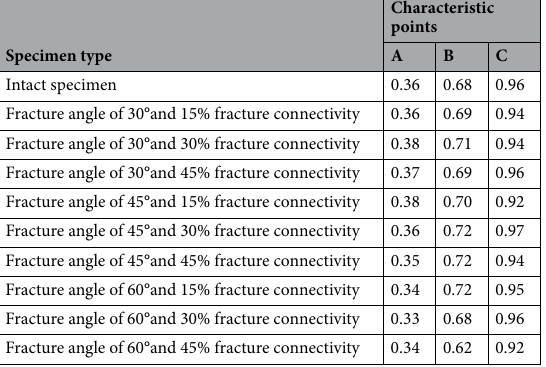
Table 7. Analysis of characteristic points of the soft rock-like specimens.